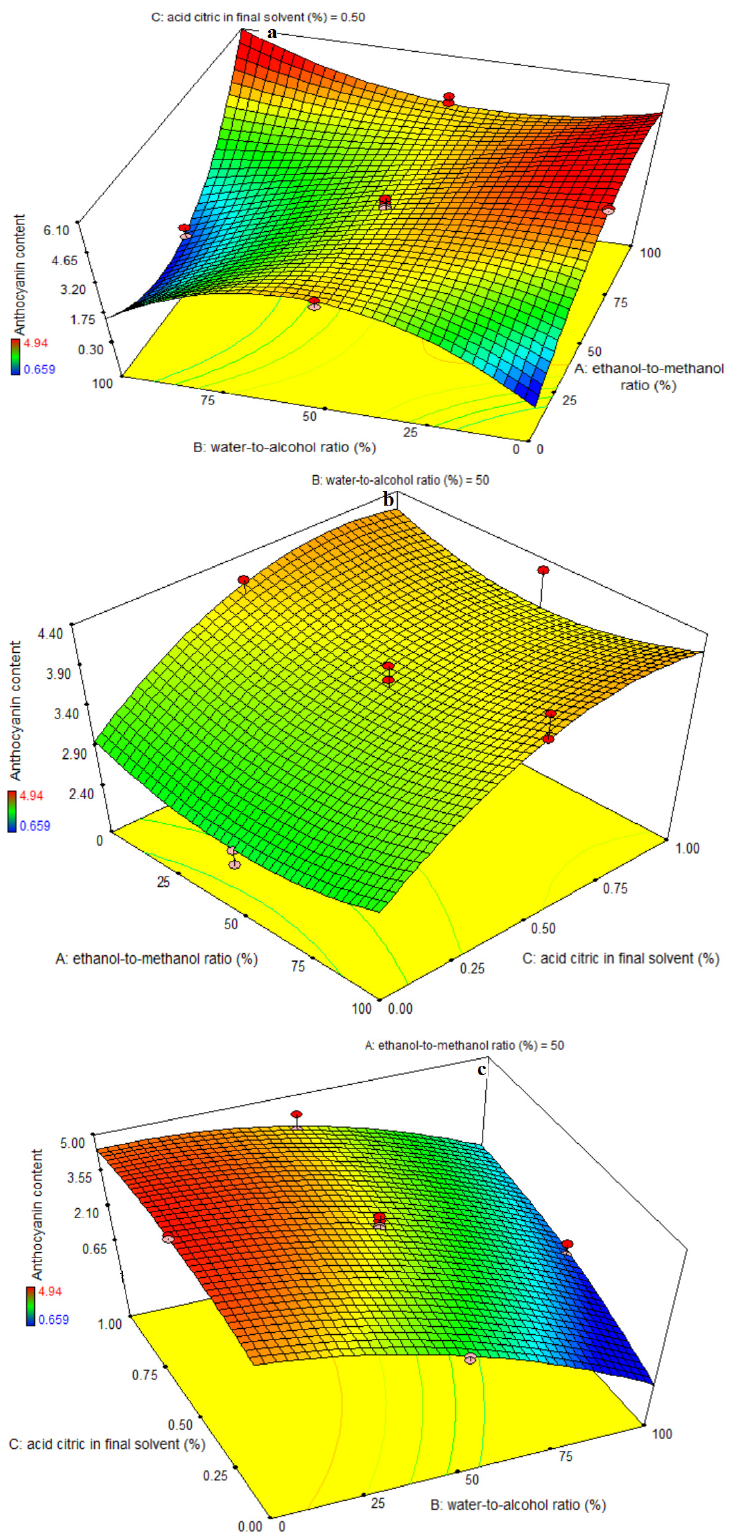
Figure 2. Effects of ethanol-to-methanol ratio (%), water-to-alcohol ratio (%) and citric acid in final solvent (%) on anthocyanin content (mg delphinidin-3-glucoside/g dry extract) in eggplant peel extraction. ( a ): The interaction effect of factors A and B on the intermediate level of factor C., ( b ): The interaction effect of factors A and C on the intermediate level of factor B., and ( c ): The interaction effect of factors B and C on the intermediate level of factor A.